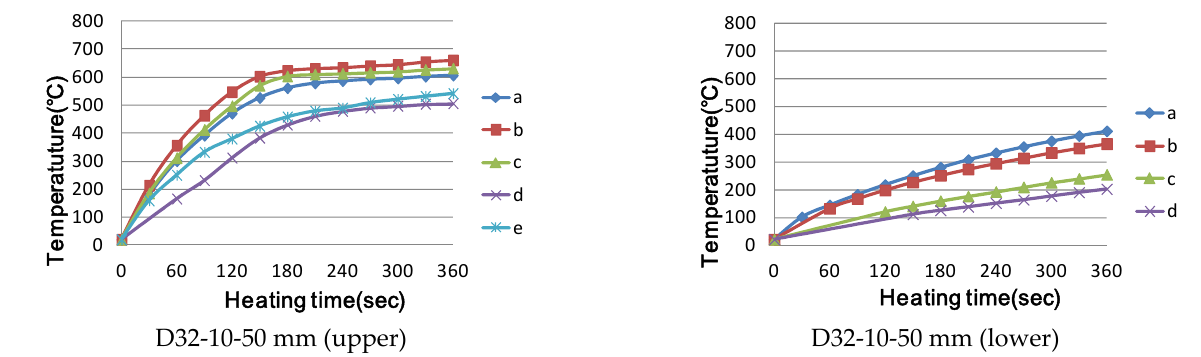
Figure 16. Temperature characteristics of crossed reinforcing bar (10 W).